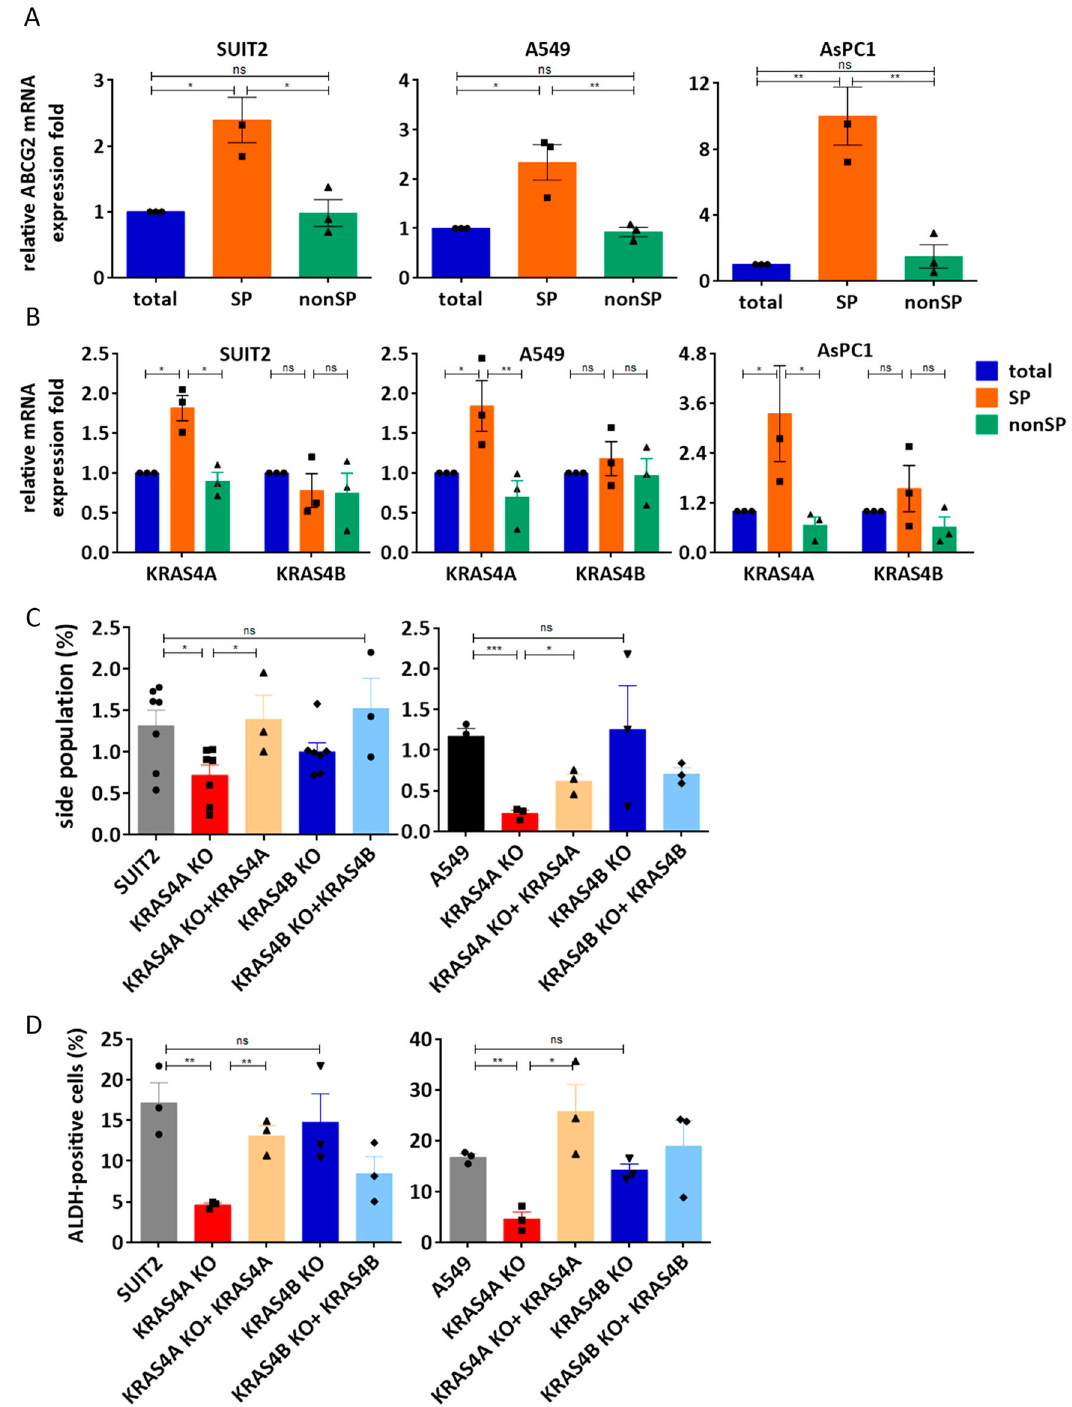
Fig. 4 KRAS4A regulates stemness properties in human cancer cells. Stem cell side populations (SP) were assessed in A549, SUIT2 and AsPC1 cells by Hoechst 33342 staining. A ABCG2 levels were signi fi cantly increased in side population cells from all 3 cell lines. Data are presented as mean ± s.e.m from n = 3 independent experiments. * P < 0.05; ** P < 0.01 by one-way ANOVA with Tukey ’ s multiple comparison. B KRAS4A , but not KRAS4B was signi fi cantly increased in levels by TaqMan analysis of side population cells. Data are presented as mean ± s.e.m from n = 3 independent experiments. * P < 0.05; ** P < 0.01 by one-way ANOVA with Tukey ’ s multiple comparison. C , D Loss of KRAS4A reduces the proportion of side population cells ( C ) as well as the expression of the ALDH side population marker ( D ). Both the proportion of side population cells and ALDH expression levels were restored by transfection of a KRAS4A expression construct using fl uorescence-activated cell sorting analysis. Data are presented as mean ± s.e.m from n = 7 independent experiments in left panel of ( C ) and n = 3 independent experiments in right panel of ( C ) and ( D ). * P < 0.05; ** P < 0.01; *** P < 0.001 by Unpaired two-tailed t-